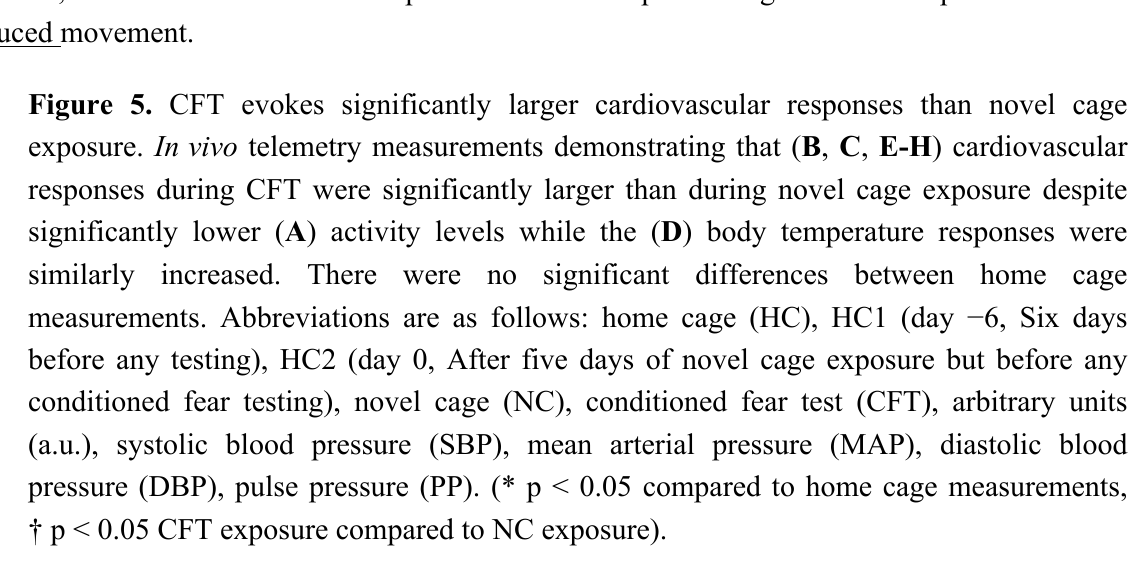
Figure 5. CFT evokes significantly larger cardiovascular responses than novel